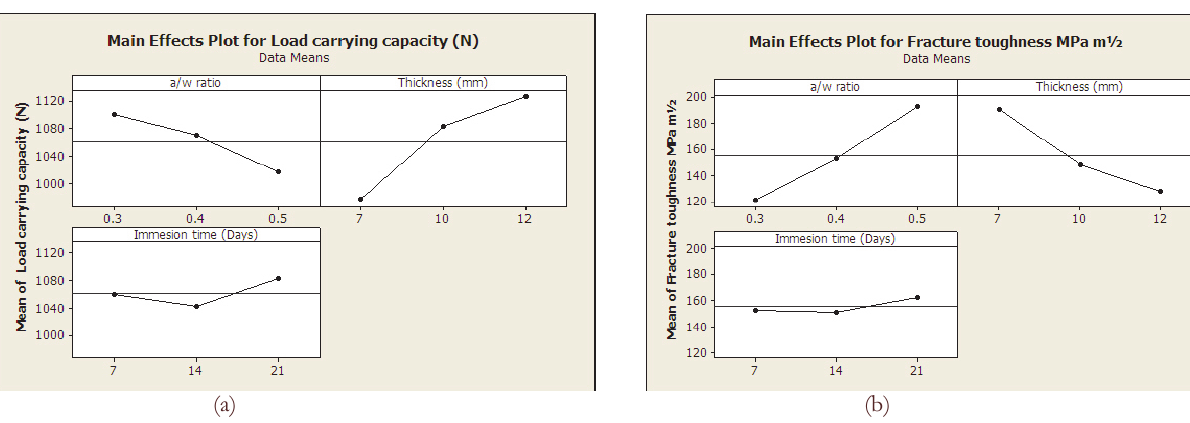
Figure 3: Main effect plot of (a) Load carrying capacity (b) Fracture toughness MPa m½.